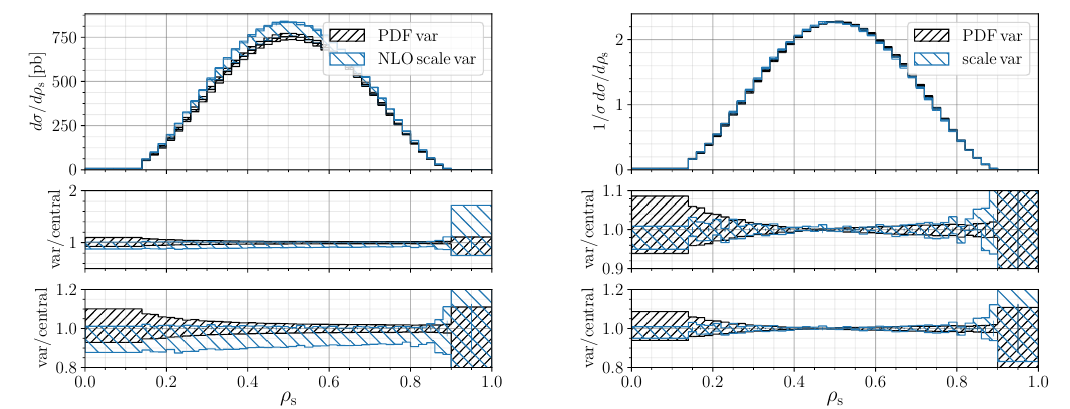
(left) and the y (right) distributions. t ¯ t t ¯ t